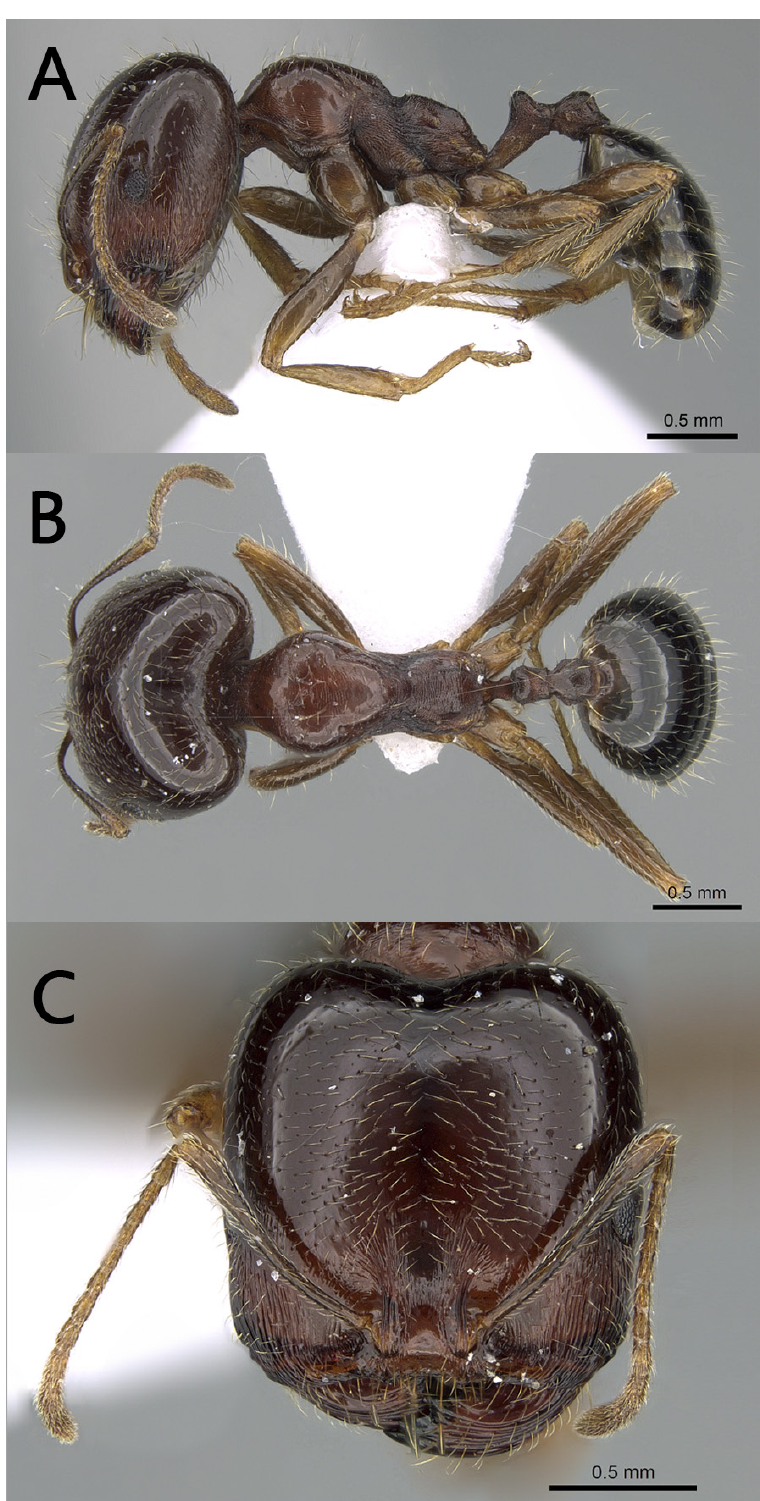
Fig. 11. Trichomyrmex perplexus (Radchenko, 1997), worker , Cyprus (CASENT0281551) . A . Body in profile. B . Body in dorsal view. C . Head in full-face view. (photos: Estella